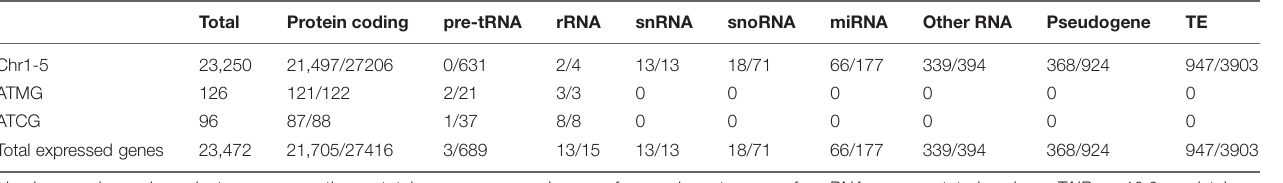
TABLE 1 | Gene type destinations mapped to TAIR 10.0 genome